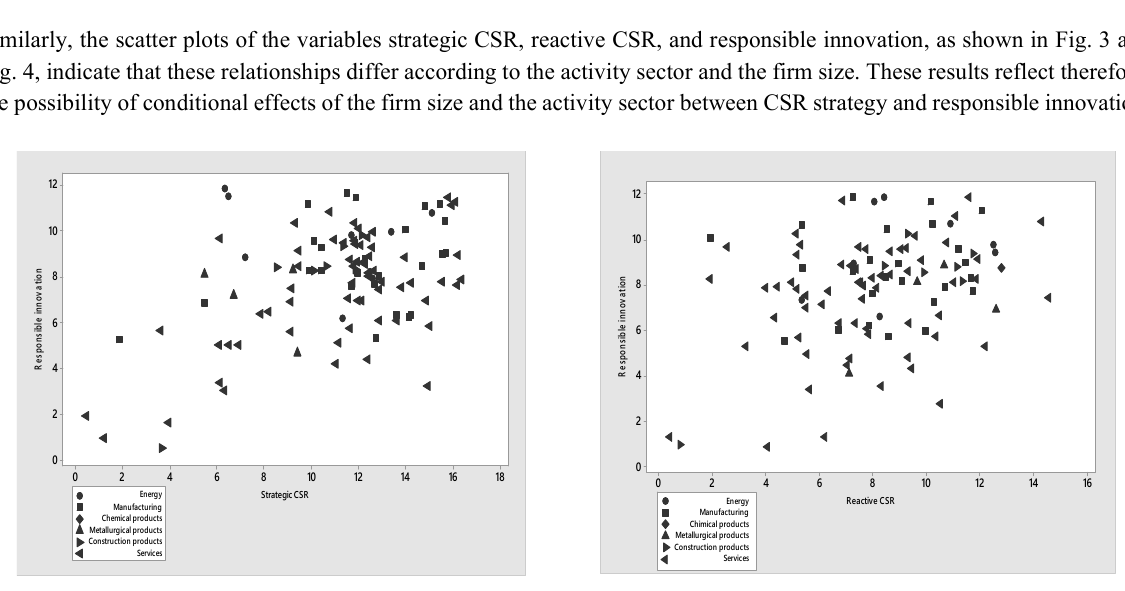
Fig. 3. Scatter plot of the variables reactive CSR, strategic CSR and competitive advantage according to the activity